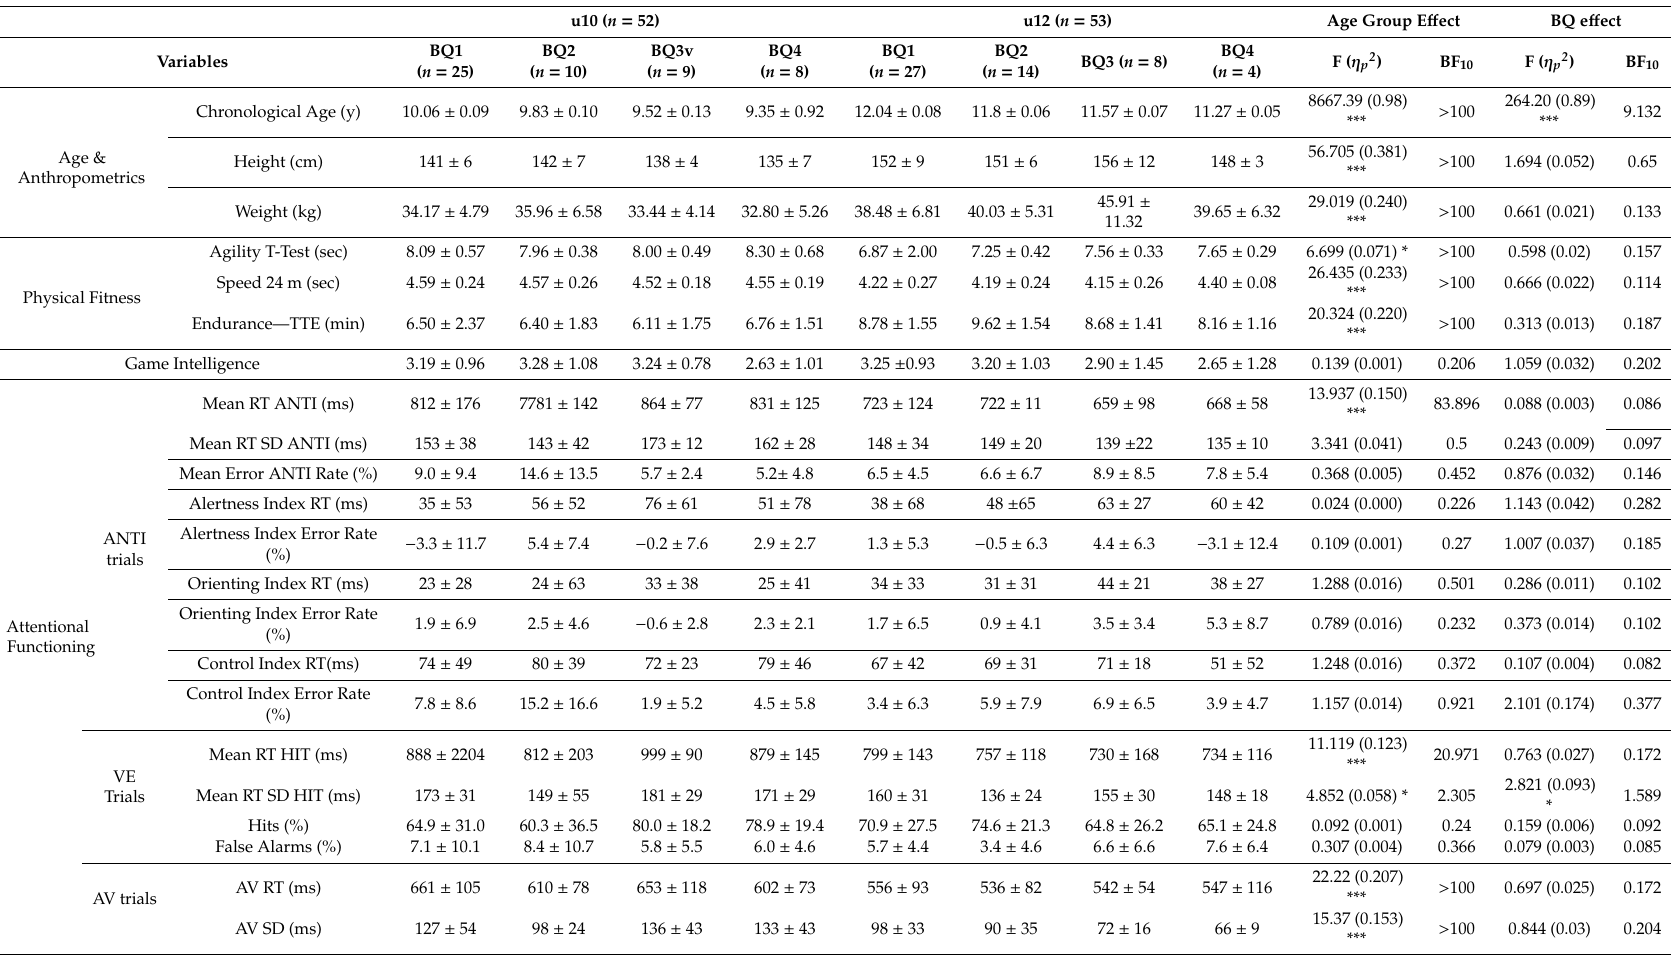
Table 1. Players’ characteristics (mean ± standard deviations) according to Age Group (u10 and u12) and Birth Quarter (BQ1, BQ2, BQ3, and